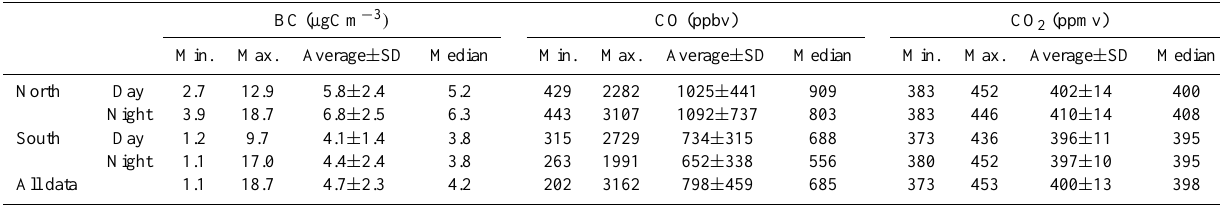
Table 2. Statistics of BC, CO, and CO 2 observed in different categories at Guangzhou. The daytime and nighttime hours were 08:00– 18:00h and 20:00–06:00h, respectively. To avoid any bias due to the transition phase of wind speed and MLH, the data measured during